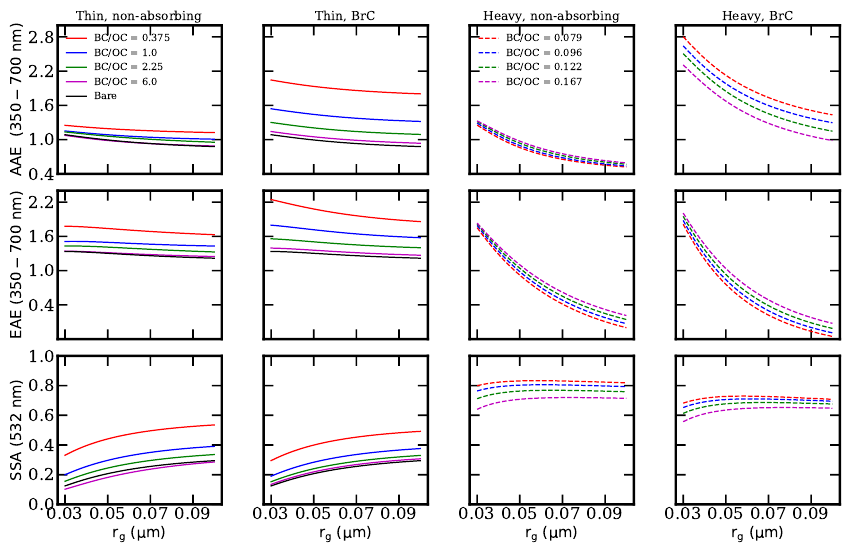
Figure 5. Radiative properties of BC as the function of r g at different mixing states, σ g =